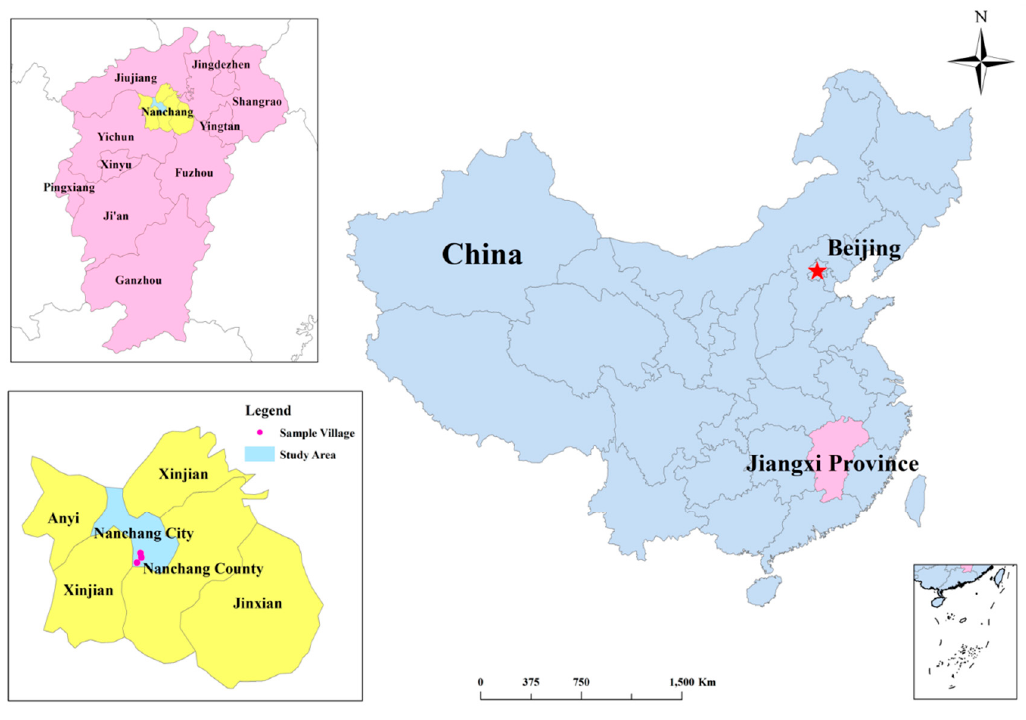
Table 3. Statistical distribution table of questionnaires.